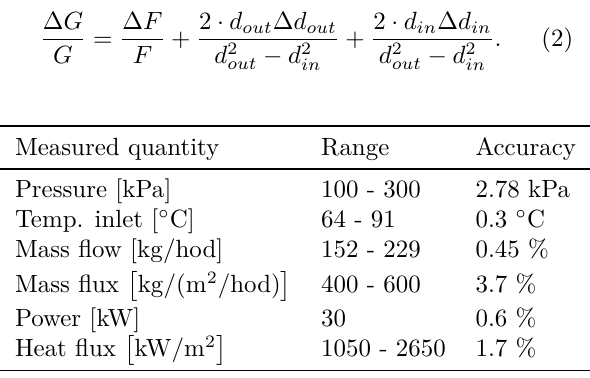
Table 4. Accuracy of measurement